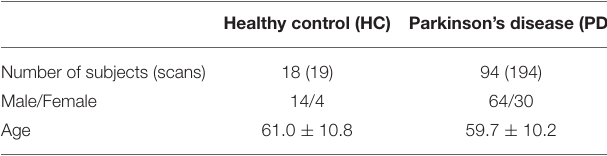
TABLE 2 | Basic statistics of subjects with fMRI scans in PPMI dataset.